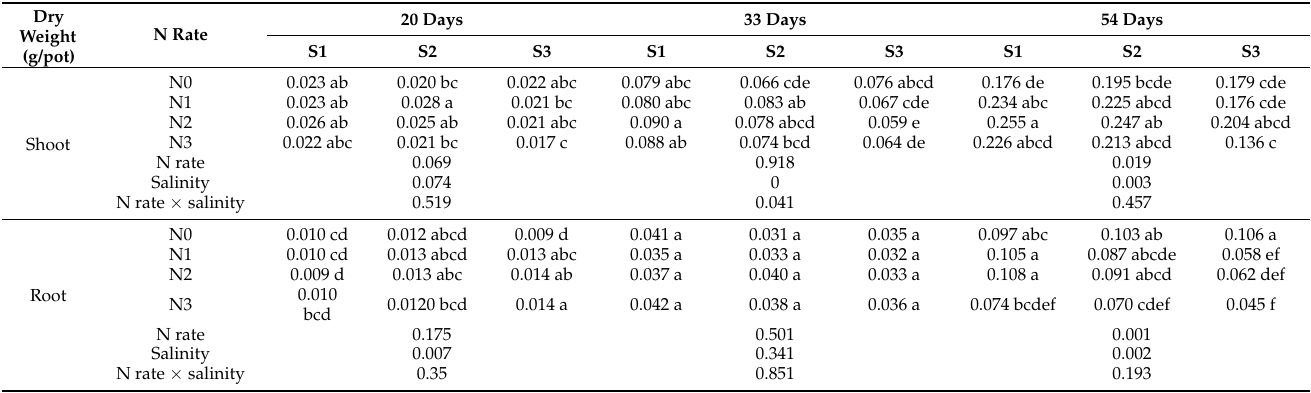
Table 8. The dry weight of shoot in different growth stages of Winter Wheat under different salinity and N application